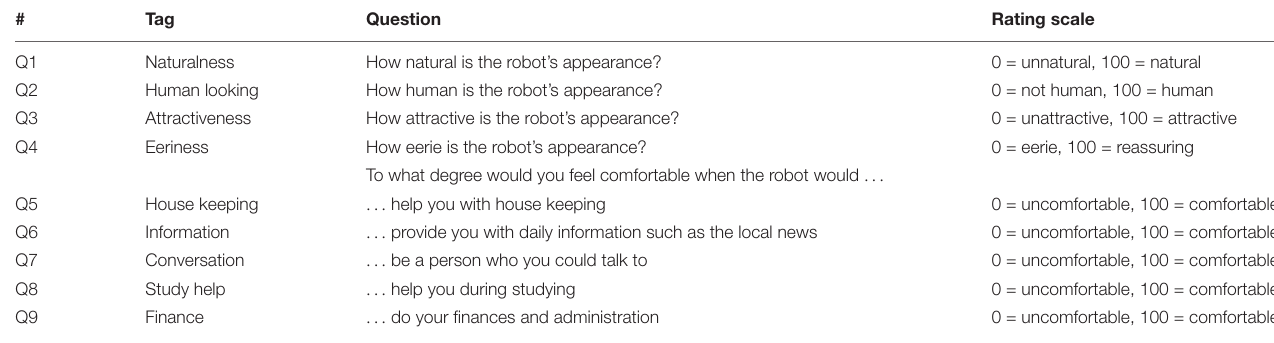
TABLE 2 | Questionnaire